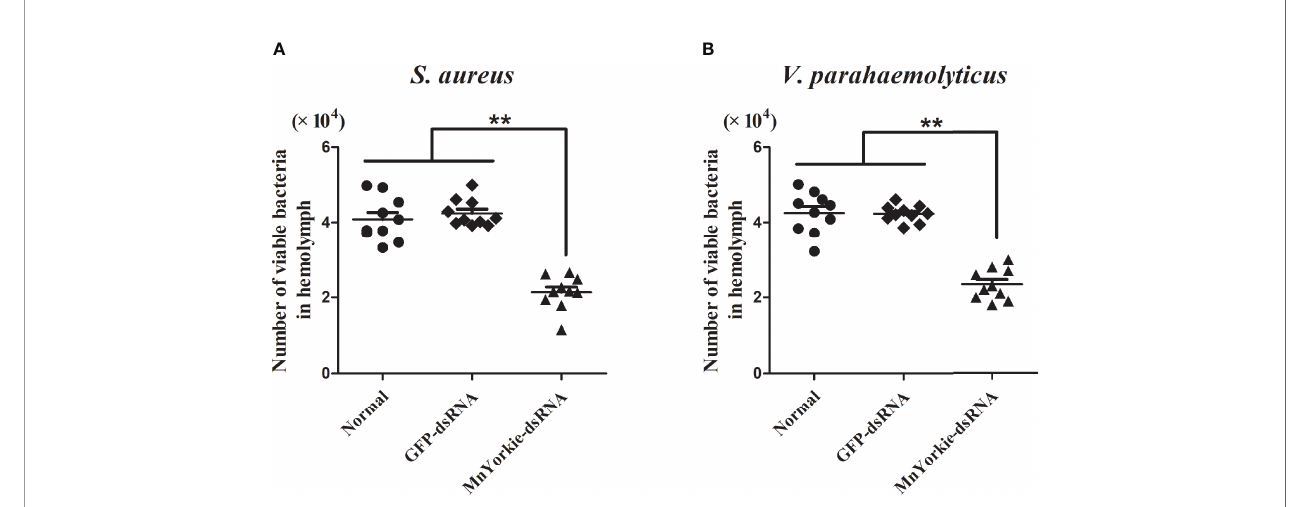
FIGURE 11 | In vivo bacterial clearance assay. 36 h after MnYorkie RNAi, the number of bacterial colonies were counted and recorded with or without injected S. aureus (A) or V. parahaemolyticus (B) at 20 min. Data are shown as mean values ± S.D. (N = 10). The asterisks indicated signi fi cant differences (** P < 0.01).